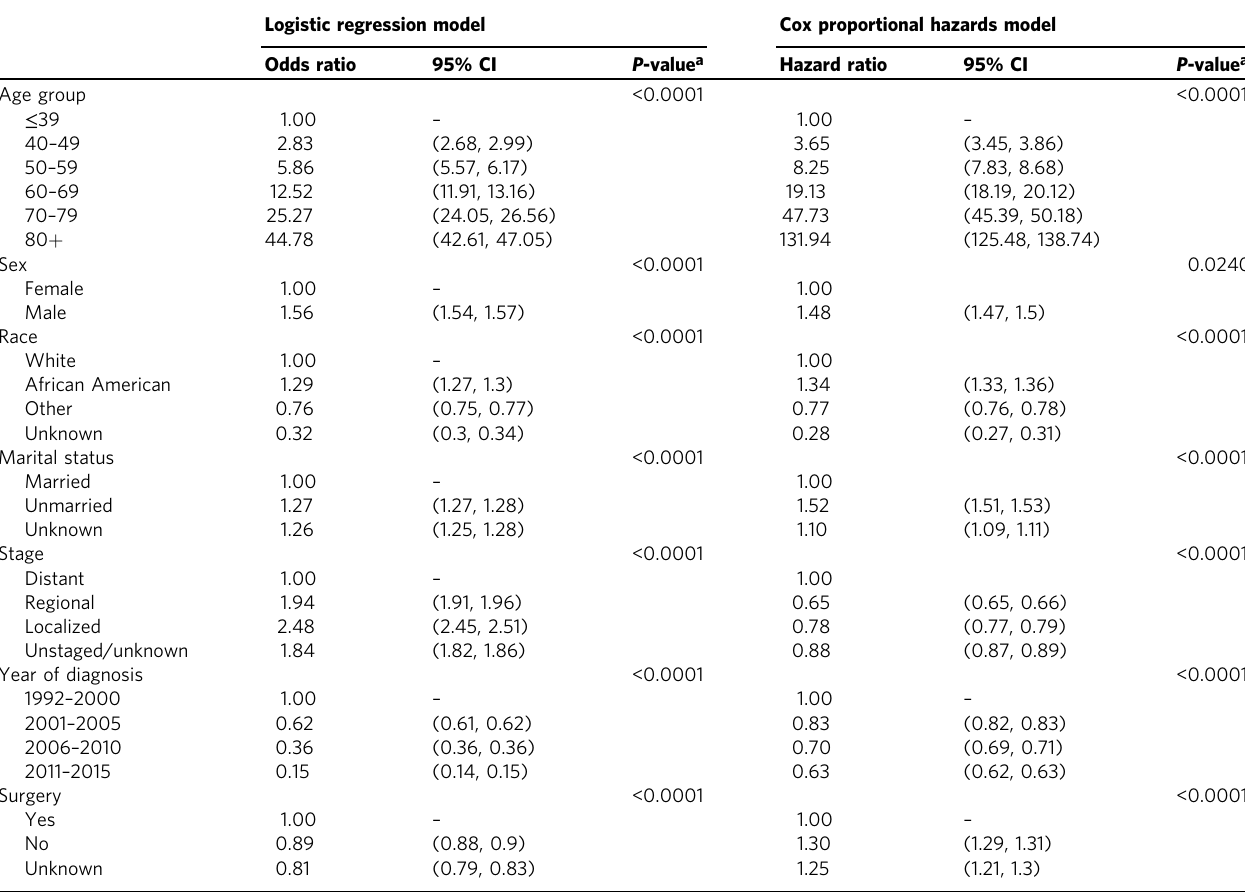
Table 2 Odds ratios and hazard ratios of fatal heart disease among cancer